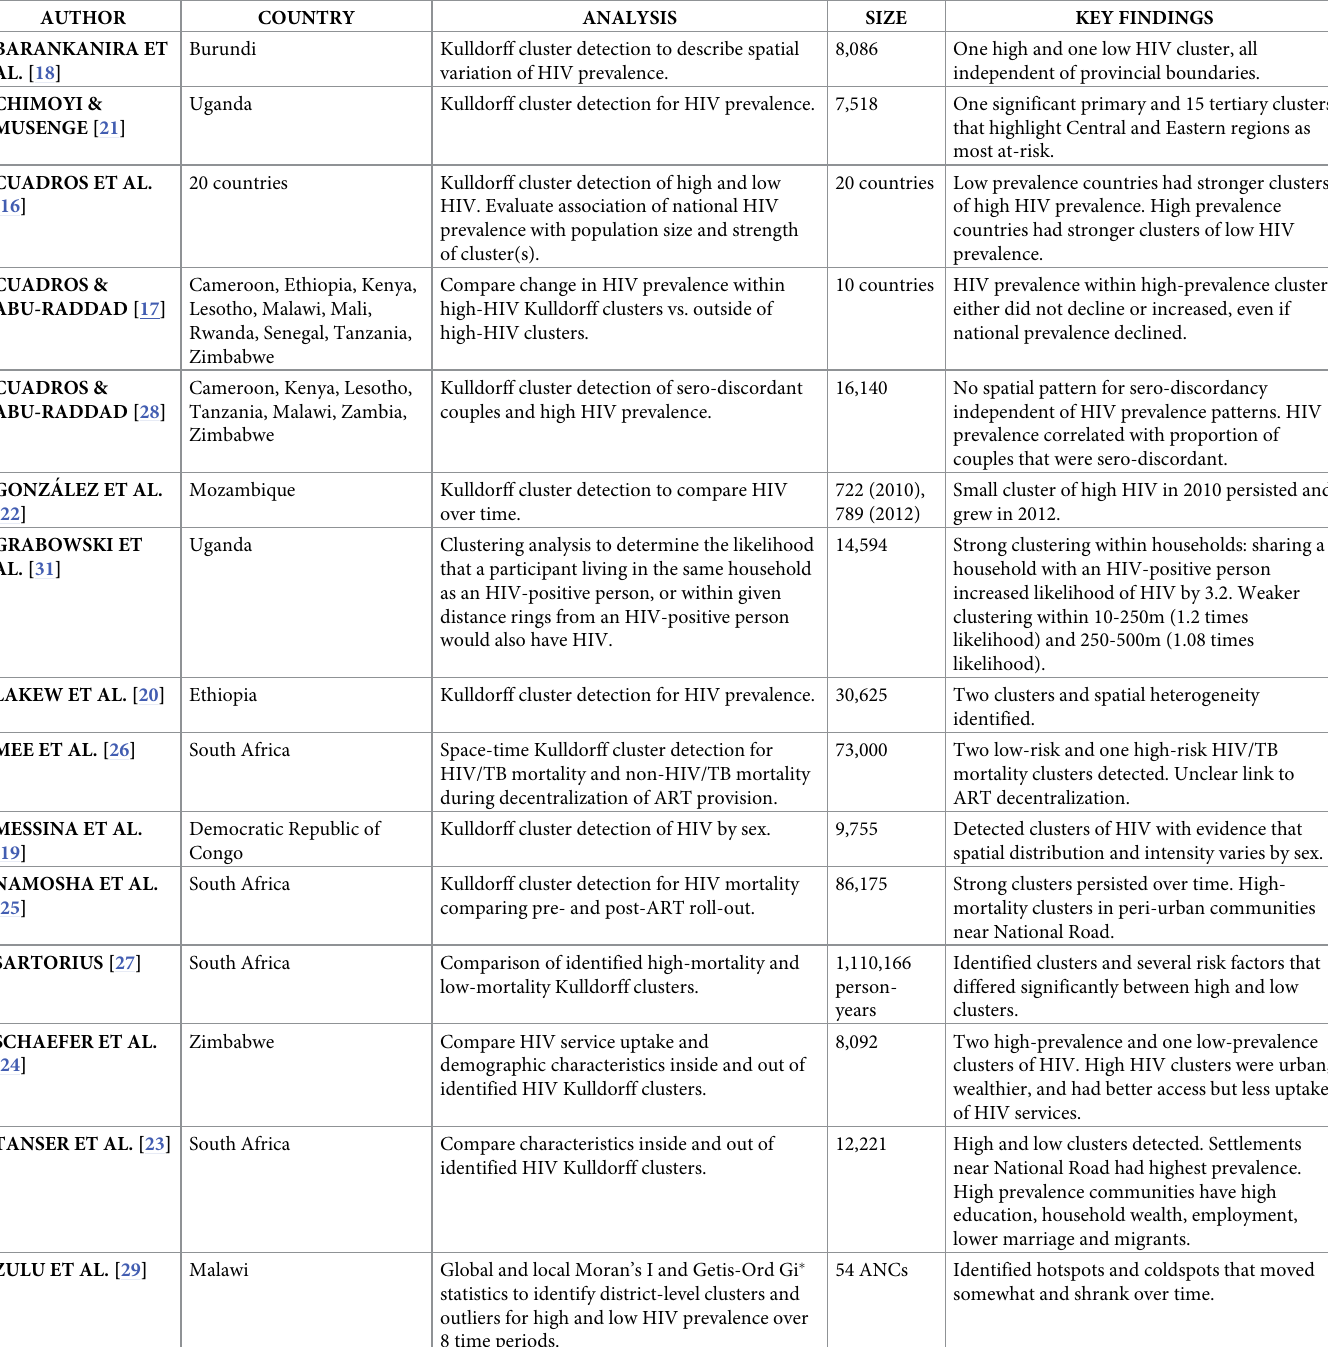
Table 1. Studies using cluster detection and clustering analysis to characterize the spatial distribution of